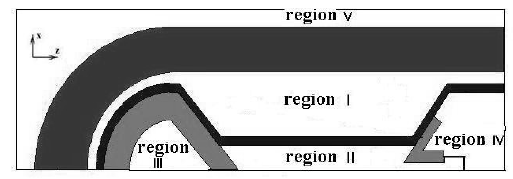
Figure 5. The calculation region for the longitudinal